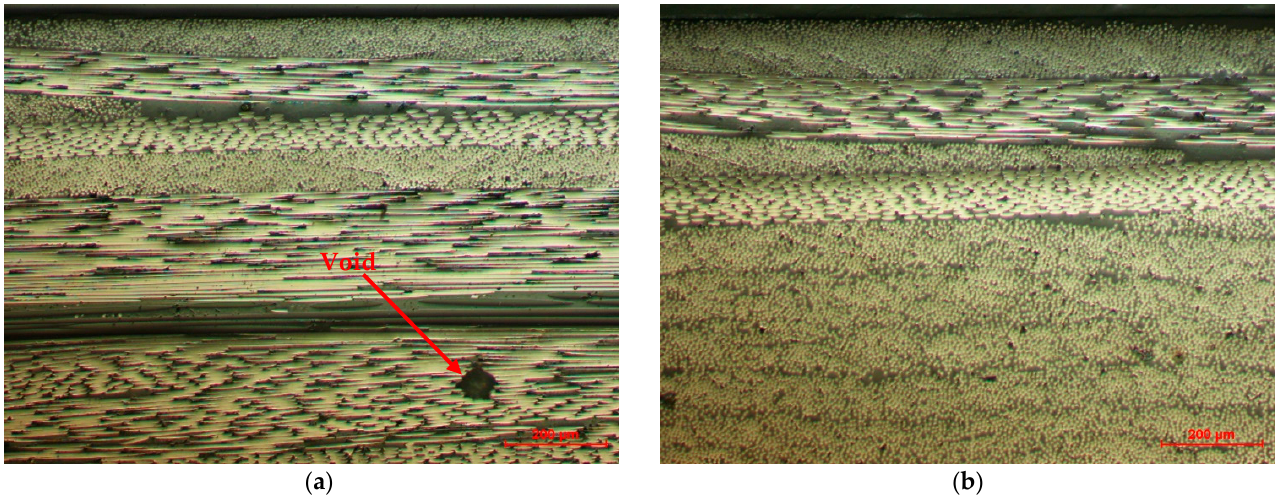
Figure 12. Microscopic analysis of CFRP landing gear: ( a ) longitudinal section (100×); ( b ) cross-section (100×).